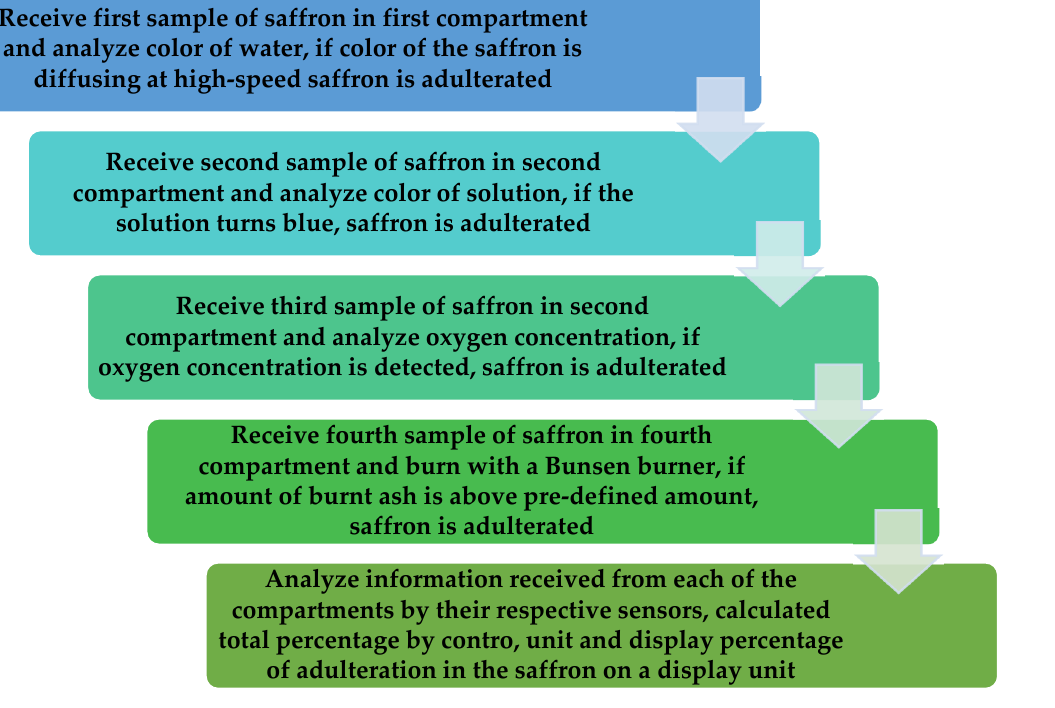
Figure 7. Flowchart of the quality check chamber.